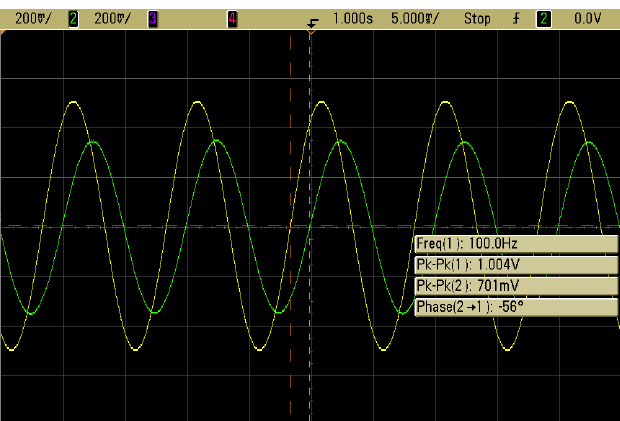
Figure 8. Experimental input and output waveforms of LP filter of order 1.5, stimulated by 1V, f = 100Hz sinusoidal